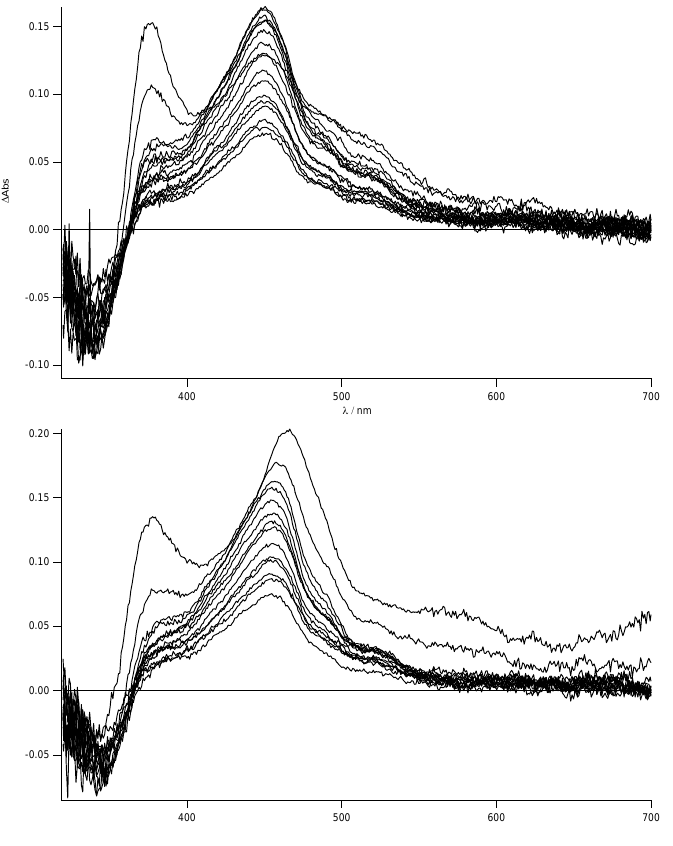
Figure 11. Top: Transient absorption transient spectra of TpyPhPyrene = 300 nm); bottom: transient absorption transient spectra of (increment 10 ns,  ex Zn(TpyPhPyrene ) in THF (increment 10 ns,  2 2